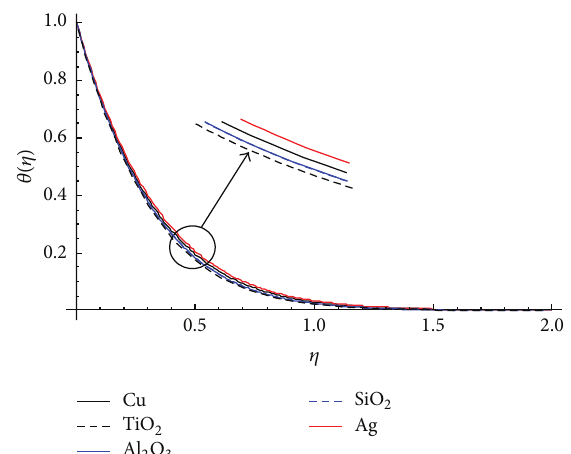
Figure 5: Comparing the variation of temperature distribution 𝜃(𝜂) for the investigated nanoparticles when 𝑃𝑟 = 6.2 , 𝛿 1 = 0.5 , 𝛿 2 = 0 , 𝑠 = 0.5 , and 𝜙 = 0.1 .